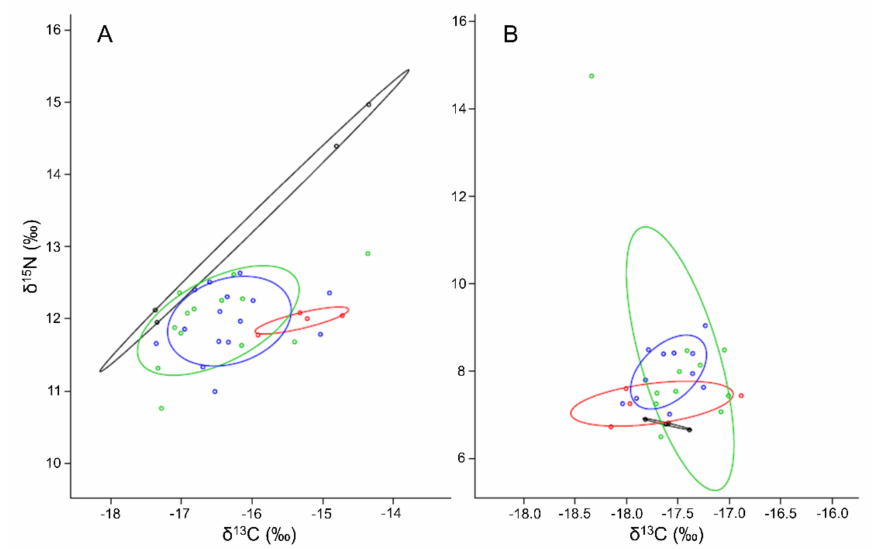
Figure 8. δ 13 C and δ 15 N bi-plots and standard ellipse corrected areas (SEAc, an ellipse that contains 40% of the data regardless of sample size). ( A ) Hediste diversicolor and ( B ) Scrobicularia plana . BS, bare sediment (black); ZNNP, Zostera noltei natural populations (red); ZNAP, Z. noltei artificial patches (green); and CNAP, Cymodocea nodosa artificial patches